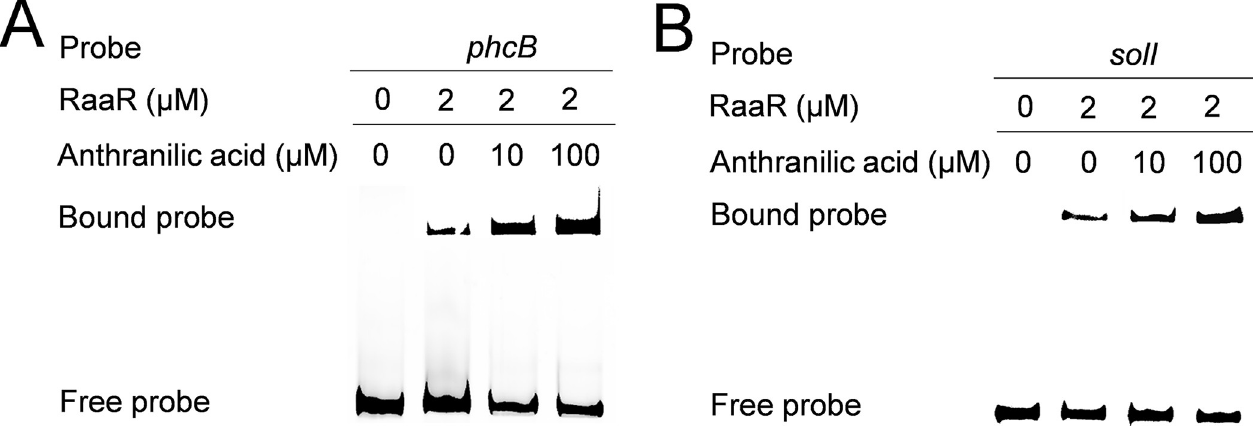
Fig 5. The effects of anthranilic acid on the binding of RaaR to the promoters of phcB (A) and solI (B) were assessed by performing EMSA in vitro . A protein- DNA complex was formed when the protein was incubated with the probe, and different concentrations of anthranilic acid had an effect on the formation of the complex at room temperature for 30